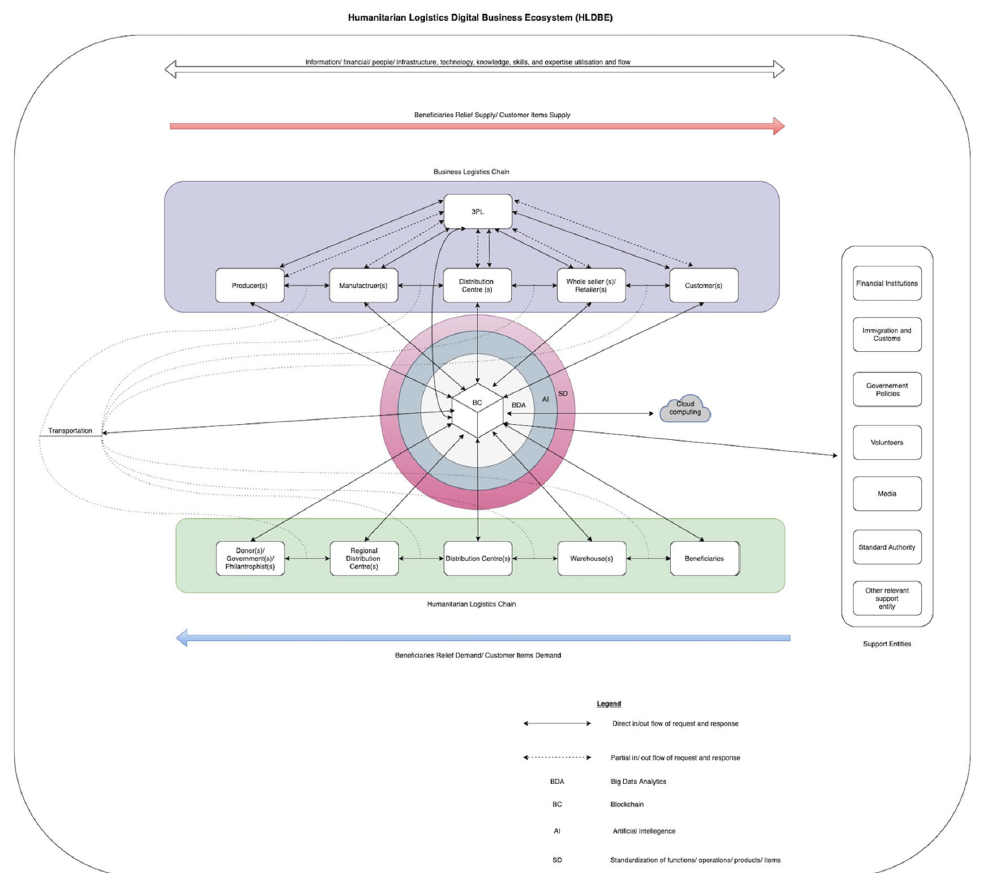
Fig. 1. An update of HLDBE (previously proposed by Baffoe & Luo, 2020). Source: This figure was proposed by Authors. Created with Draw.io